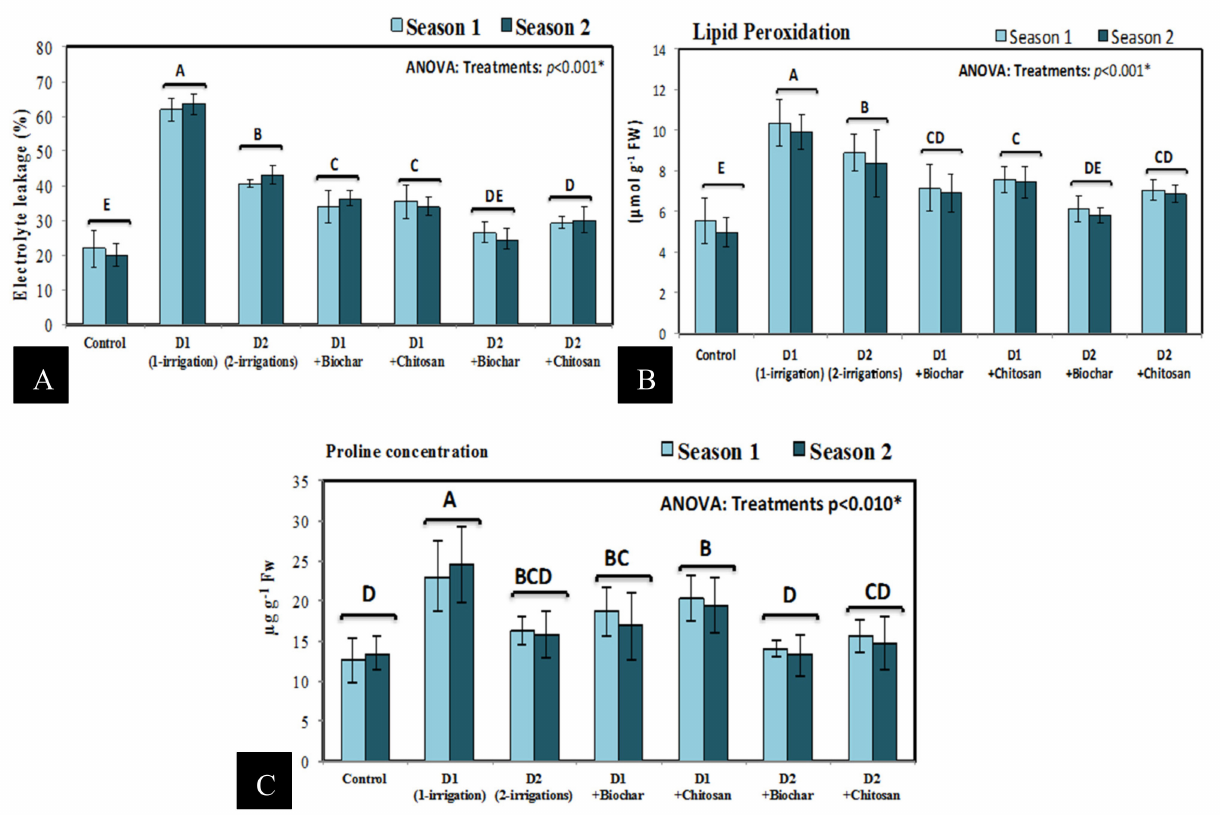
Figure 2. E ff ect of biochar and chitosan on electrolyte leakage ( A ), lipid peroxidation ( B ), and proline content ( C ) of barley during two seasons (2017 / 2018–2018 / 2019). Bars followed by di ff erent letters are significantly di ff erent at p <